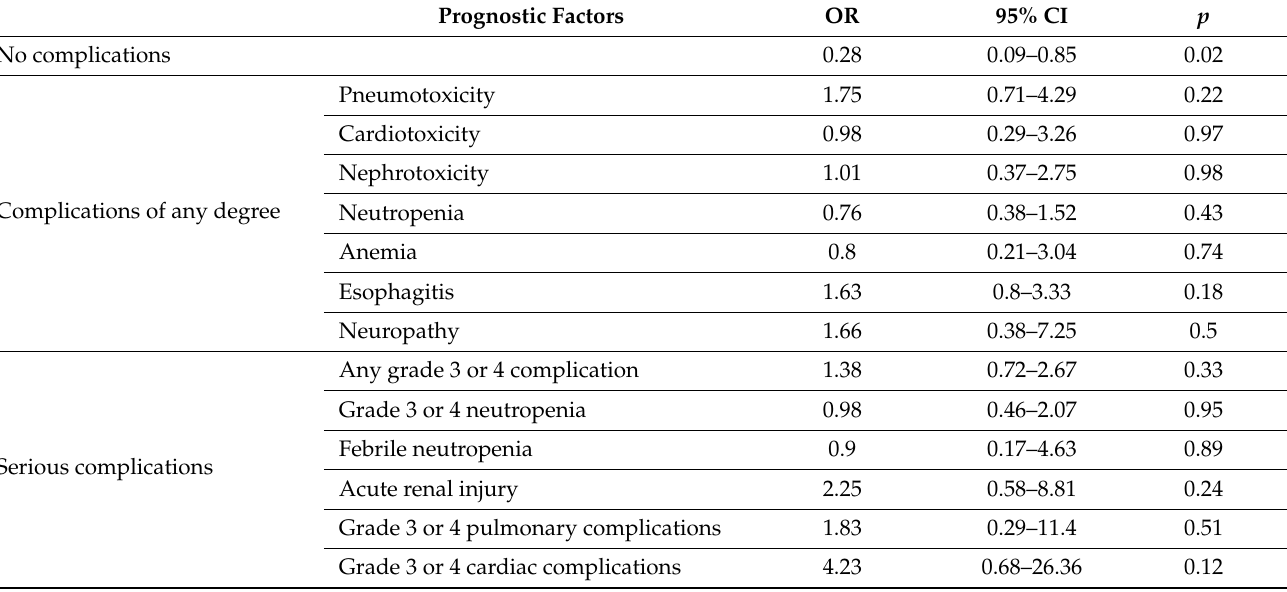
Table 5. Complications and worsening of KPS during sequential chemotherapy and radiotherapy.